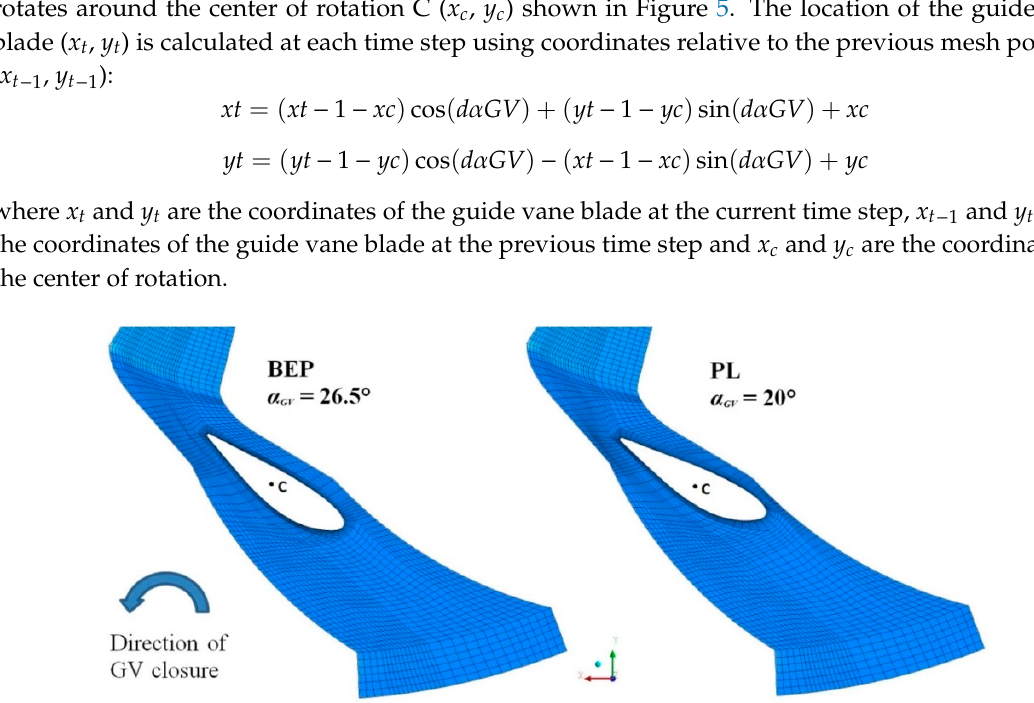
Figure 5. Spatial discretization of the guide vane domain at the beginning of the transient operation (BEP) and the end of the transient operation (PL).